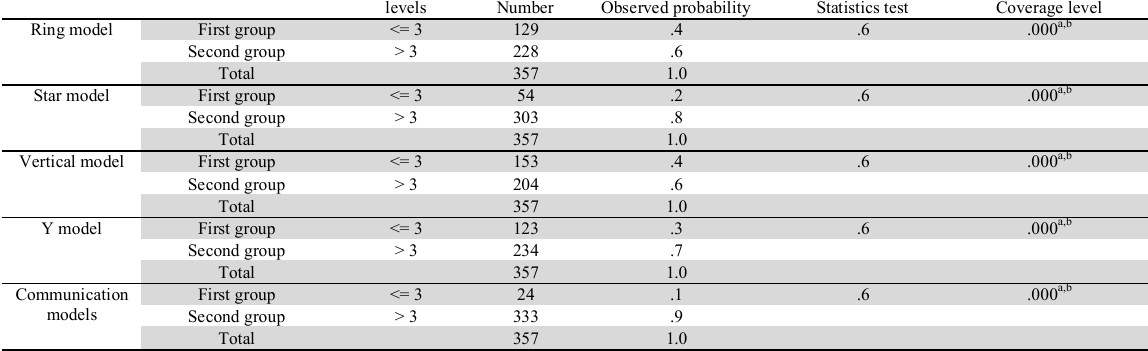
The results of binomial test